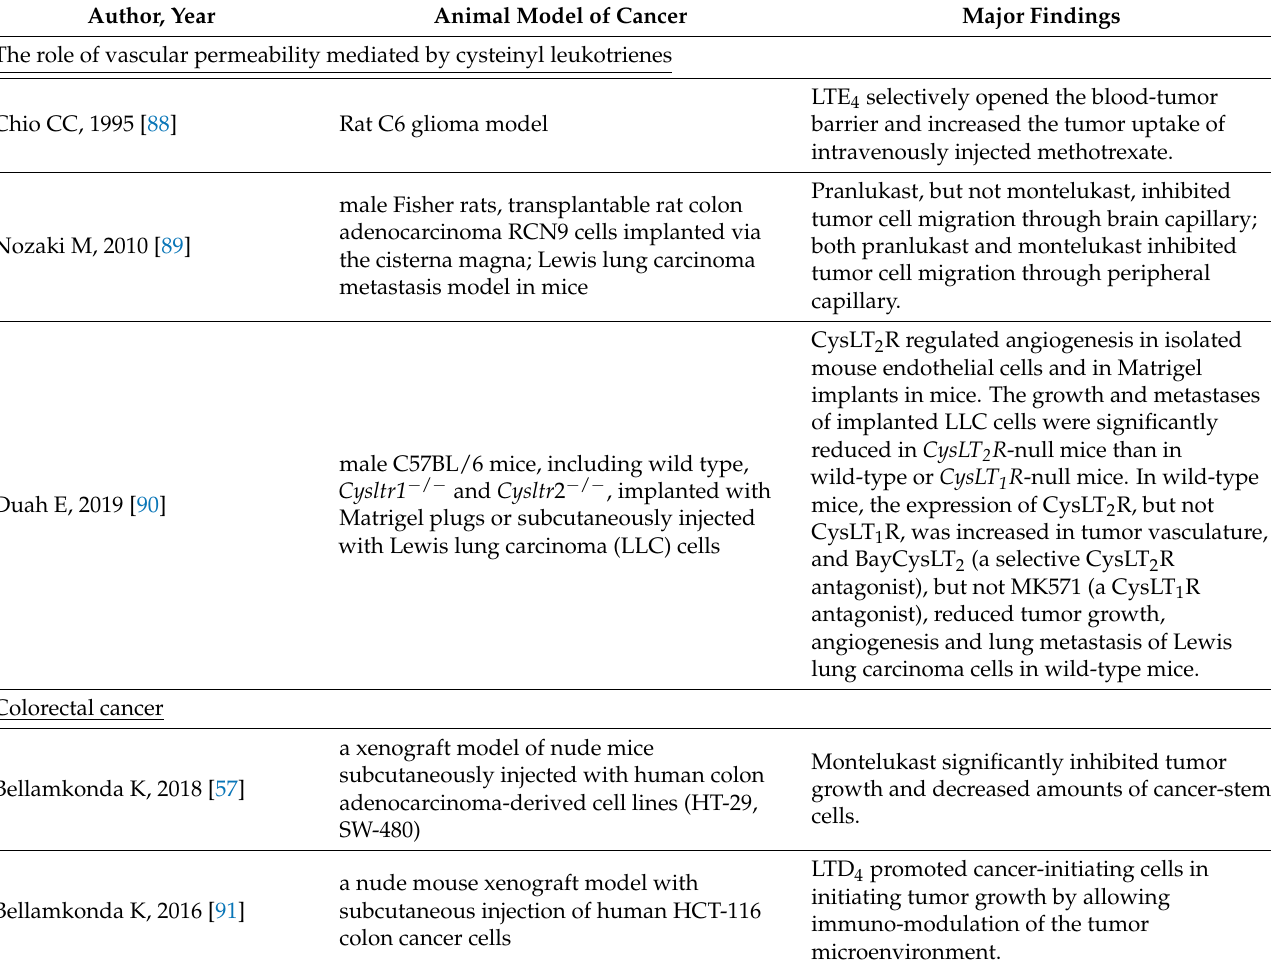
Table A2. Selected animal studies investigating the cysteinyl leukotriene pathway in